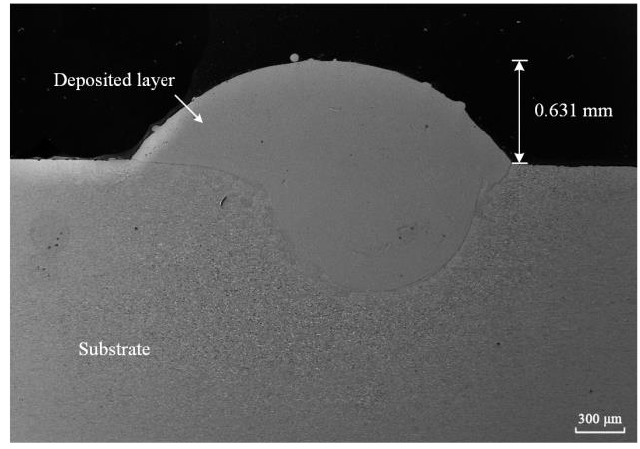
Figure 3. SEM image of the cross-section of laser-UHF induction hybrid deposited layer.